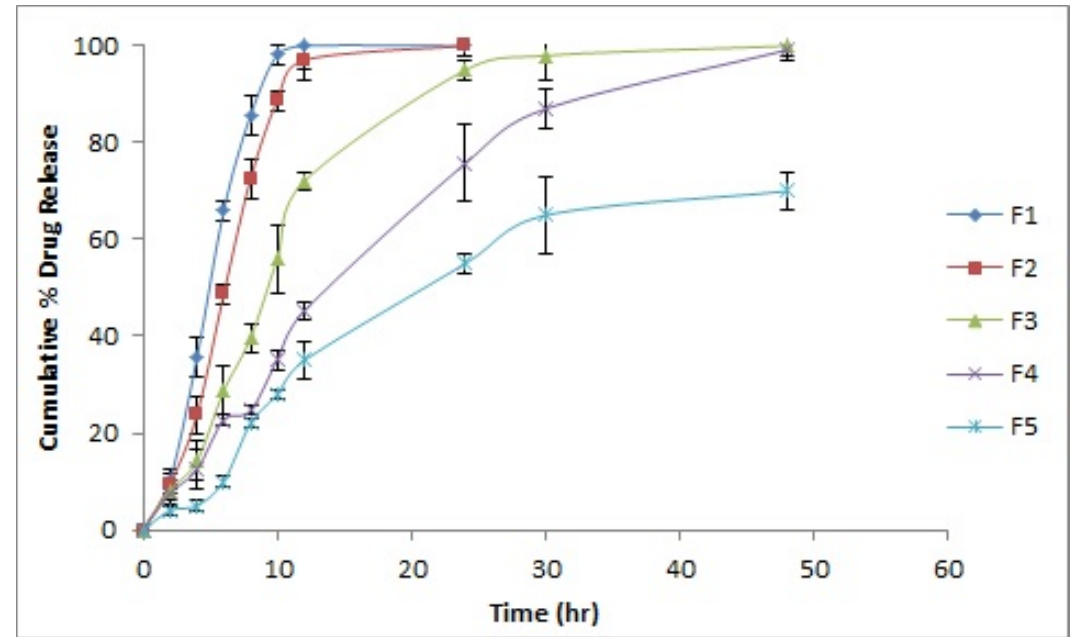
Figure 6. In vitro drug release profiles from different batches of hydrogel films.